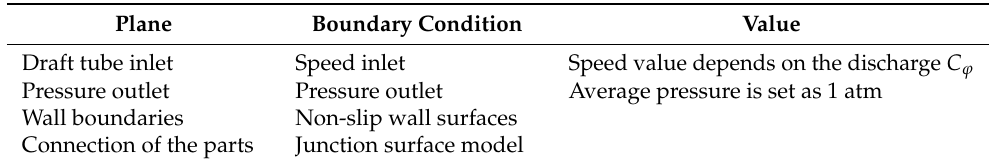
Table 3. Boundary conditions of the numerical simulation.